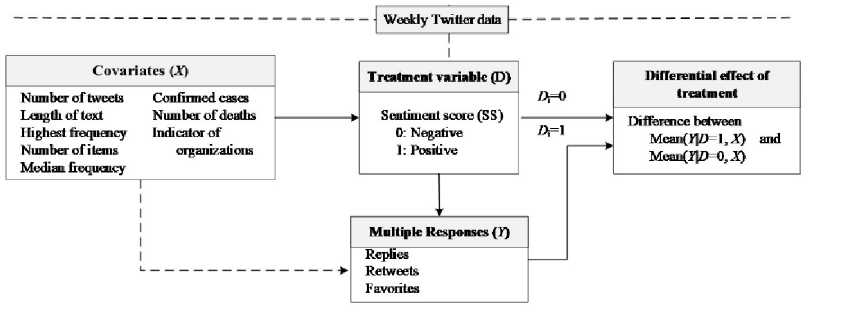
Fig 1. The study